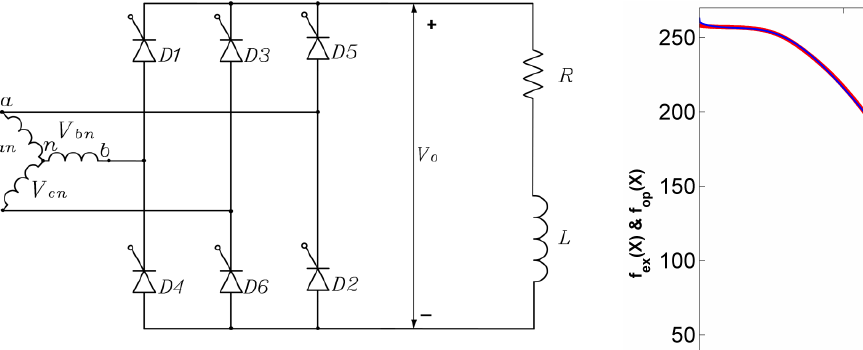
Figure 9. Power converter circuit with RL load.